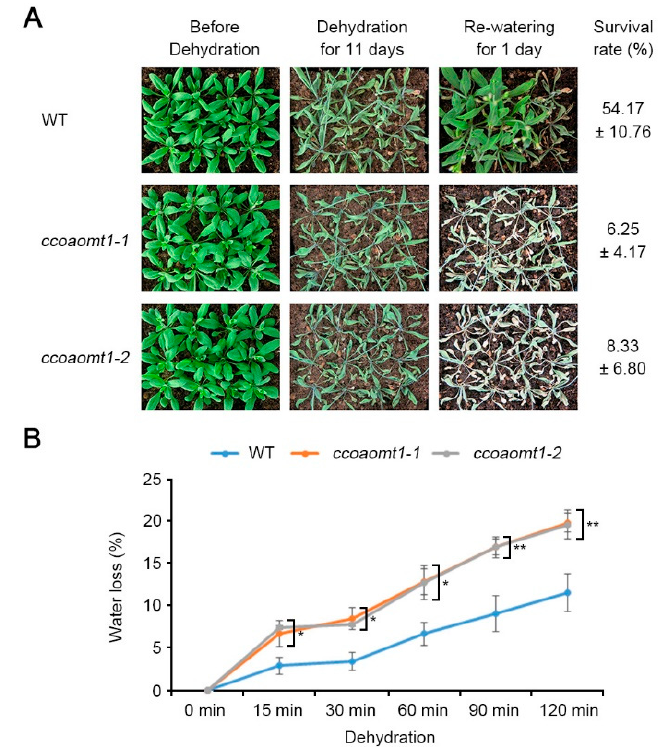
Figure 2. Hypersensitive phenotypes of ccoaomt1 mutants to dehydration stress. ( A ) Morphological phenotype before and after dehydration stress treatment. Watering of soil-grown two-week-old wild-type (WT) and ccoaomt1 mutants ( ccoaomt1-1 and ccoaomt1-2 ) was stopped for 11 days and survival rate was calculated at 1 day after rewatering and photos were taken. ( B ) Water loss of WT and ccoaomt1 mutants during dehydration stress treatment. Water loss was calculated with percentage value (%) from the weight loss versus initial fresh weight from three-week-old plants. The quantitative values indicated means ± SD of three independent experiments. Asterisks represent significant differences from the WT (*, p < 0.05; **, p < 0.01; Student’s t -test).